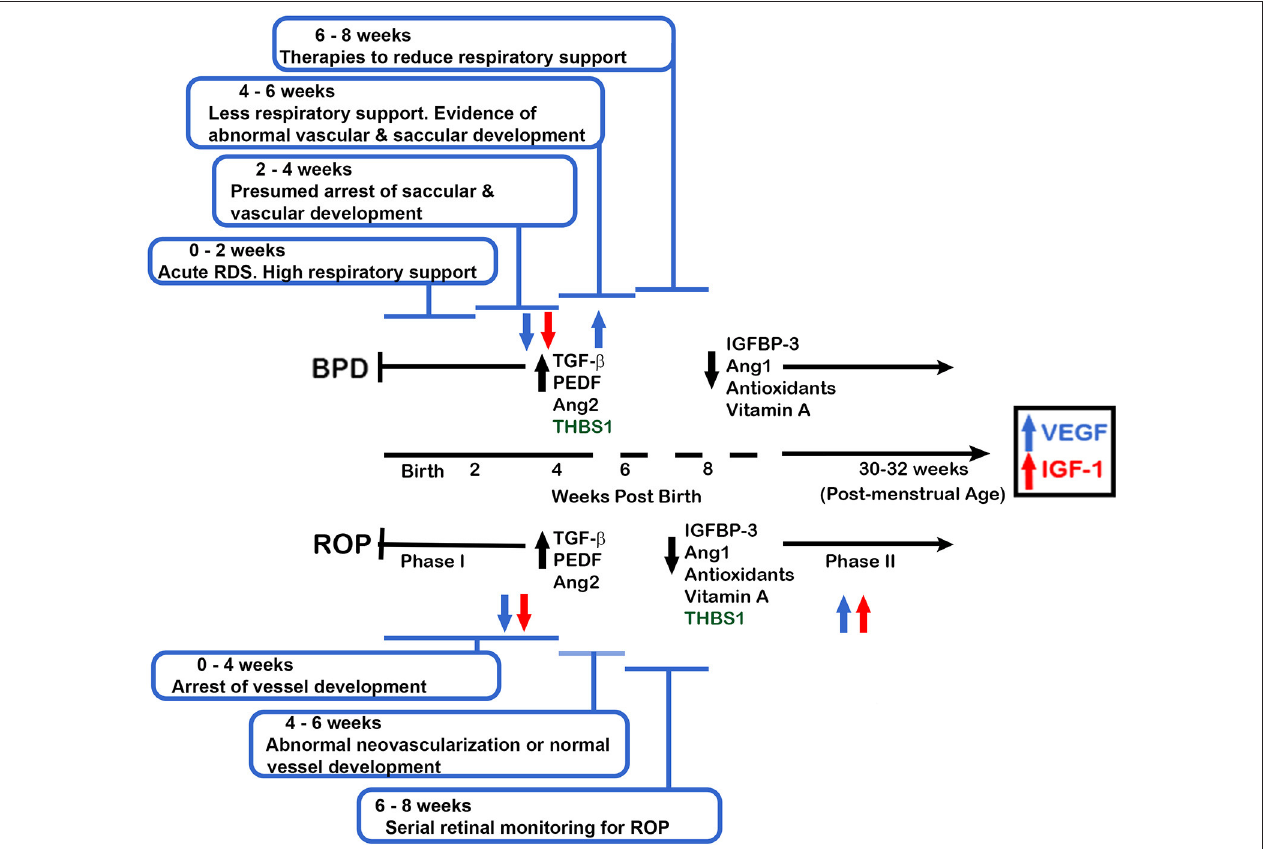
FIGURE 1 | Proposed clinical timeline depicting the current understanding of BPD and ROP disease development. The data are coordinated with the changes in expression and function of the vascular factors common to BPD and ROP. Using a gestational age of 24 weeks at birth, and current BPD and ROP clinical symptoms and definitions, an infant is determined to have or not have BPD at 36 weeks PMA (approximately 12 weeks of age) but will have clinical signs of developing BPD prior to that time. Phase 1 ROP occurs prior to 31 weeks PMA whereas Phase 2 (development of neovascularization) is believed to occur at 30-32 weeks PMA (6–8 weeks of age for an infant born at 24 weeks gestation). Abbreviations are as documented in